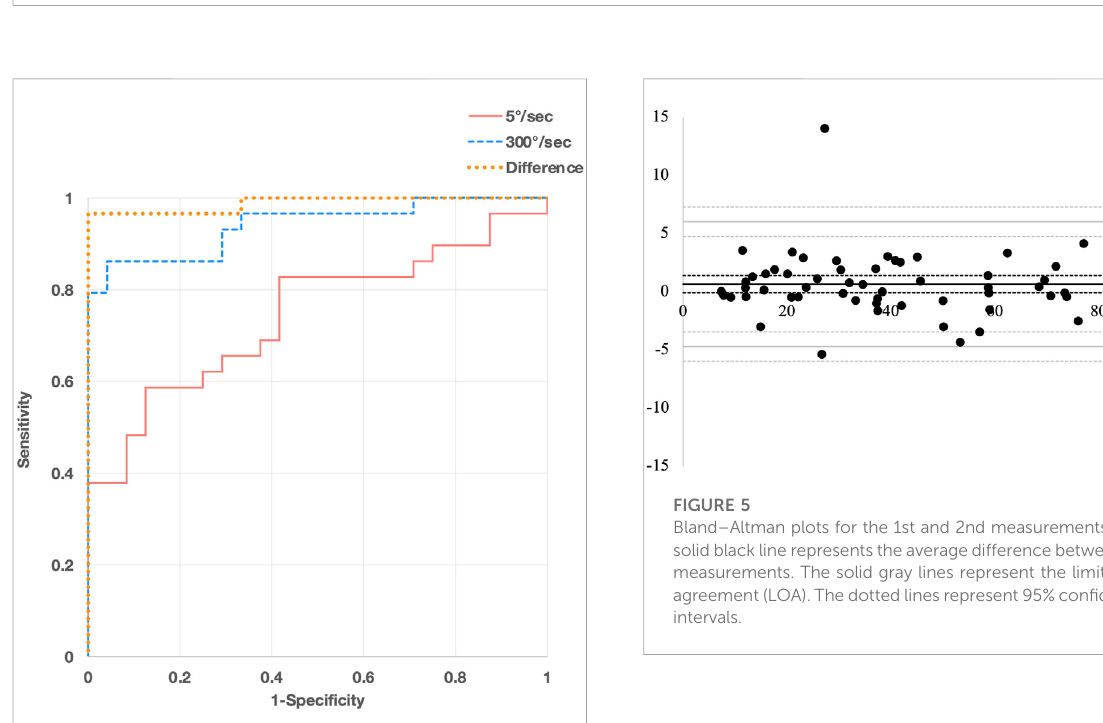
plantar fl exors on the affected side was as follows: 0 ( n = 3), 1 ( n = 10), 1+ ( n = 10), 2 ( n = 7), and 3 ( n = 2). In the control group, the peak resistance force was 17.2 ± 10.2 N at 5 ° /s and 22.6 ± 9.6 N at 300 ° /s, and the difference between the two conditions was 5.4 ± 2.6 N (mean ± SD). In the patient group, the peak resistance force was 29.3 ± 16.8 N at 5 ° /s and 53.5 ± 21.1 N at 300 ° /s, and the difference was 24.3 ± 12.0 N. The difference in the resistance force between the control group and each MAS subgroup is shown in Figure 3. The rank correlation coef fi cient between the resistance force and the MAS score was as follows: 5 ° /s, r s = 0.50 ( p < 0.01); 300 ° /s, r s = 0.84 ( p < 0.01); difference value (300 ° /s - 5 ° /s), r s = 0.88 ( p < 0.01). The